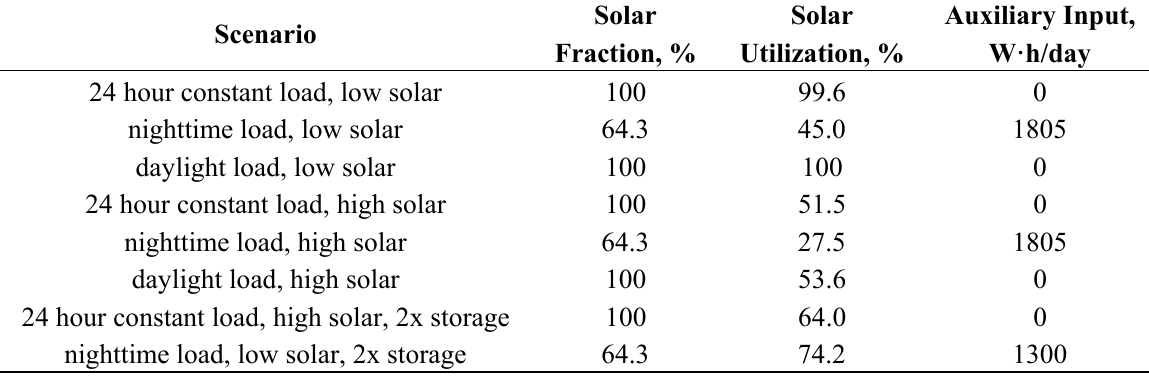
Table 1. Summary of energy performance metrics for the six